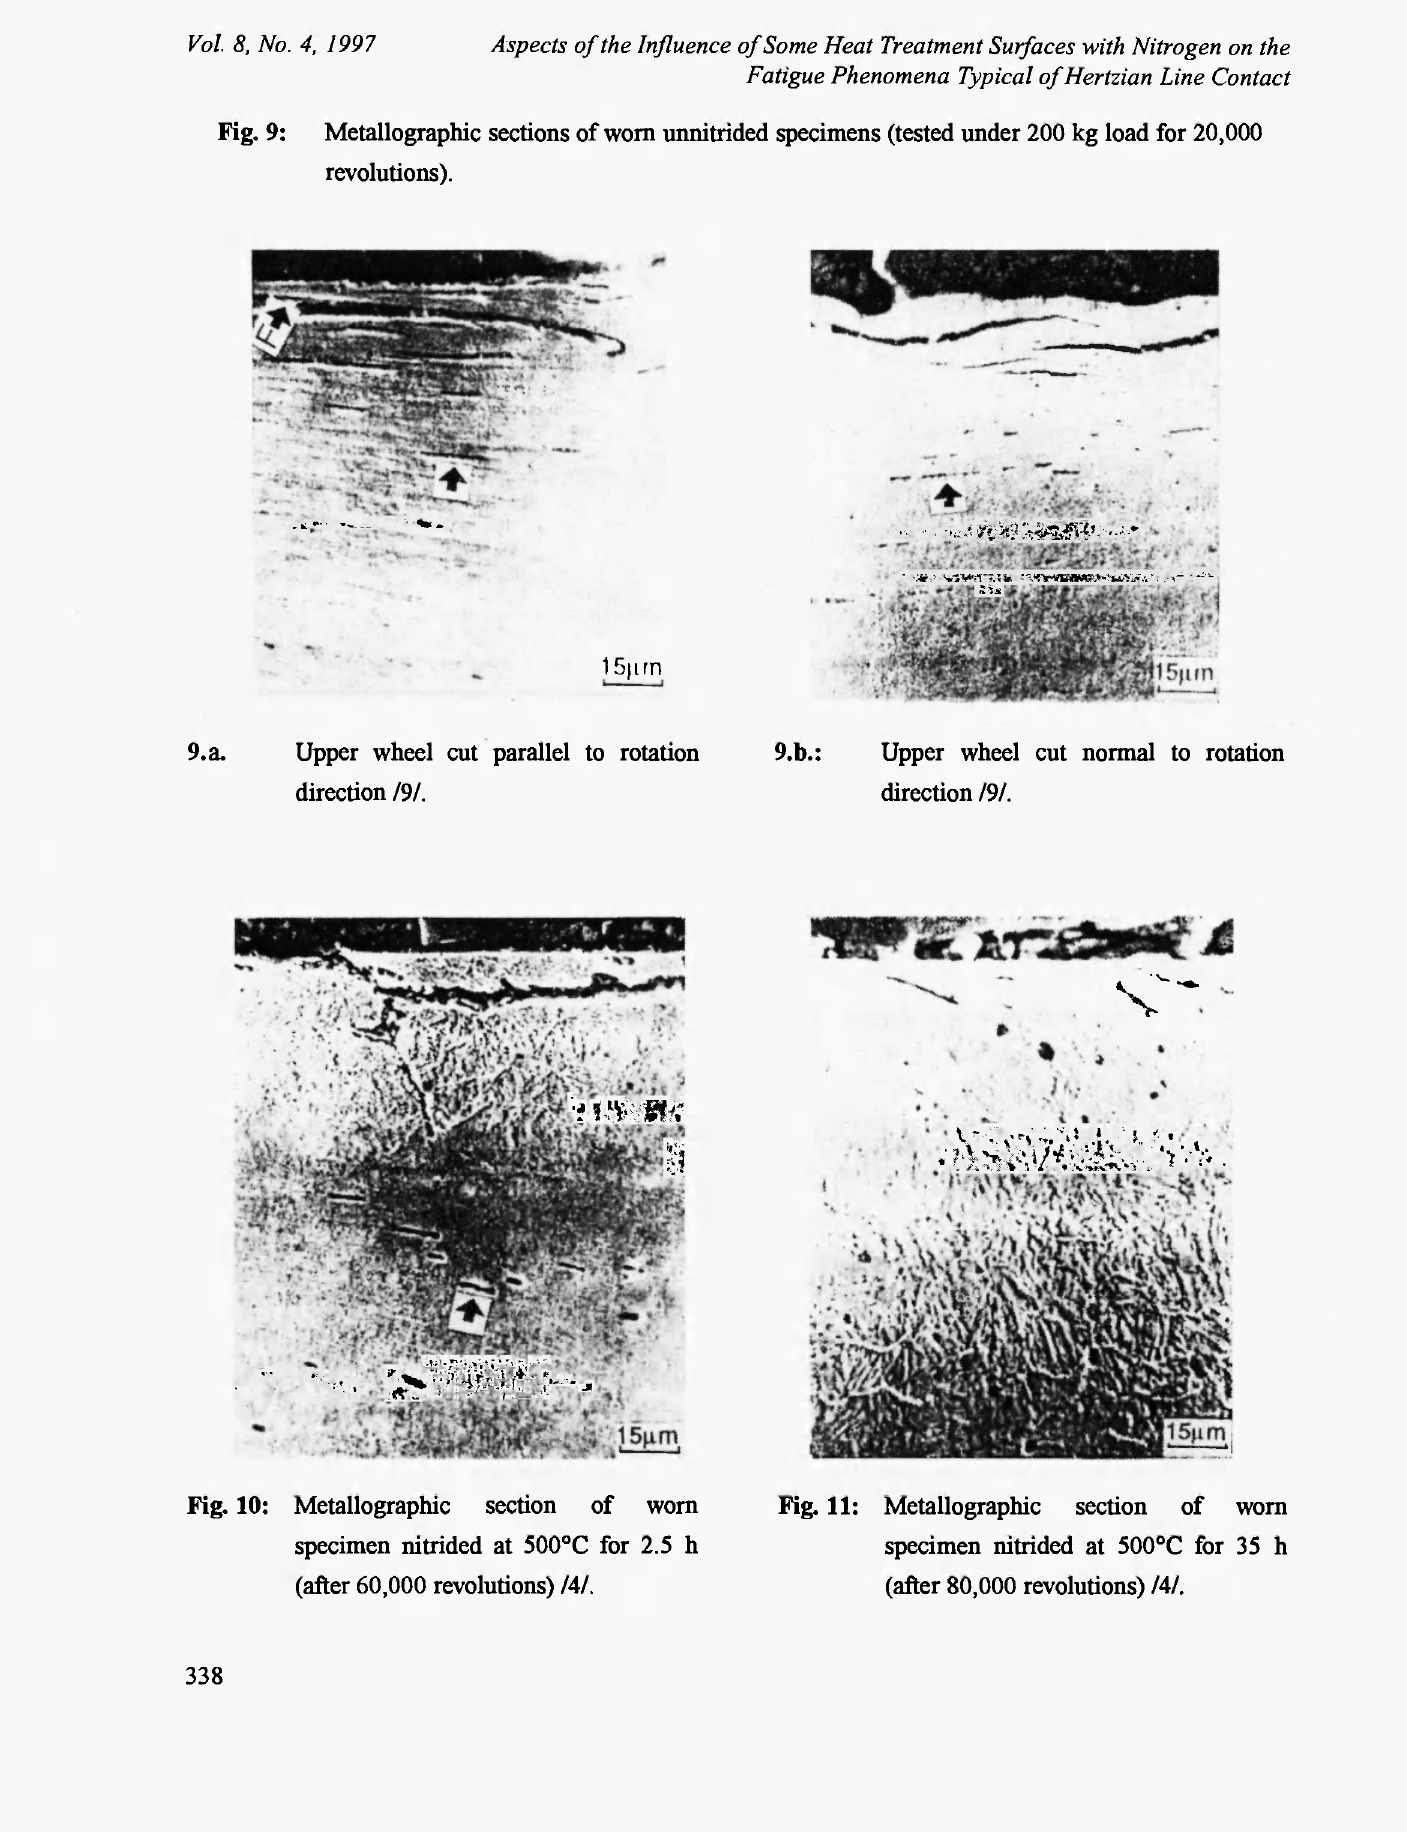
Fig. 10: Metallographic section of worn specimen nitrided at 500°C for 2.5 h (after 60,000 revolutions) /4/.